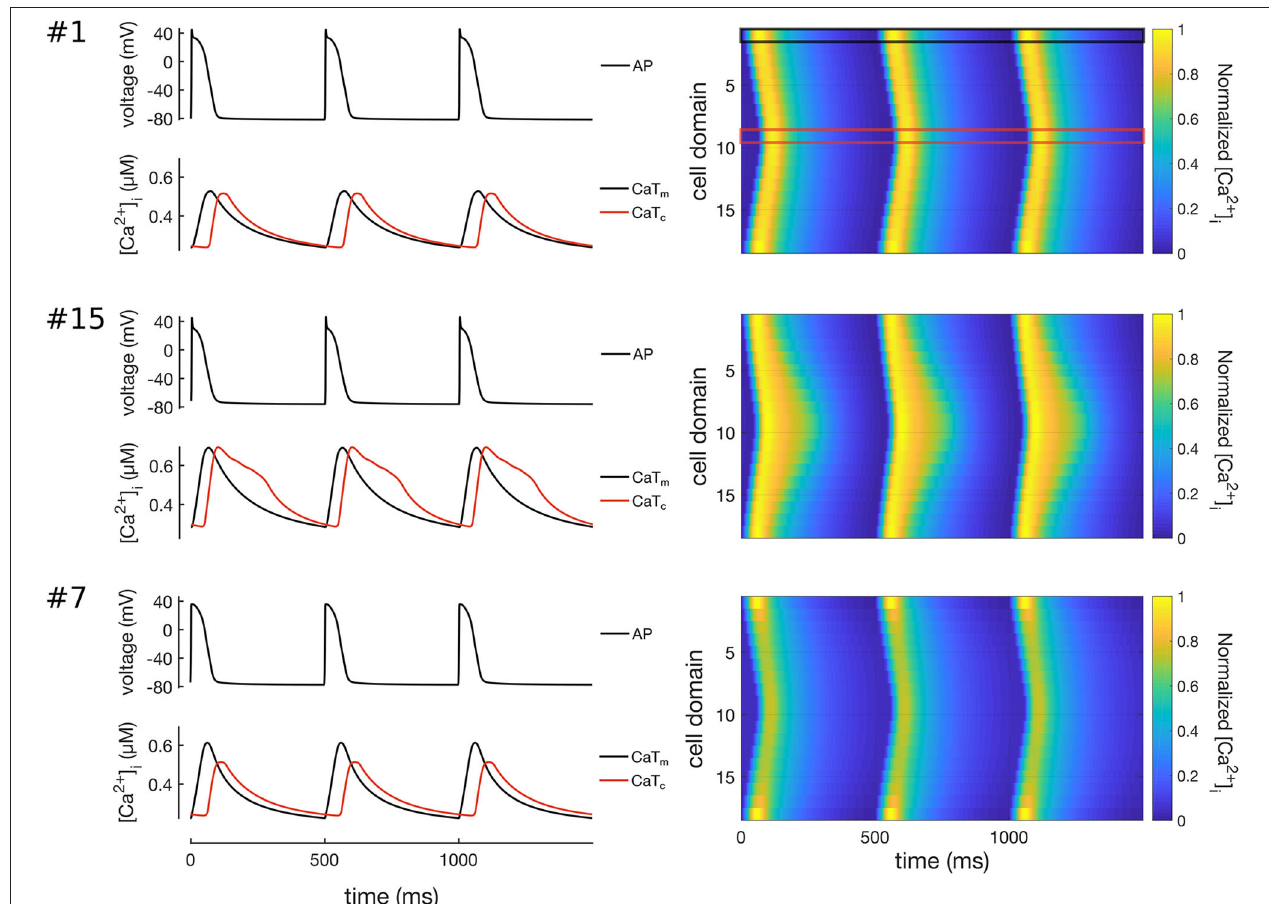
FIGURE 6 | Simulation of Ca 2 + waves in three representative models of the control population (models #1, #7, and #15). Traces on left hand-side show the APs (top), CaTs (bottom) at the membrane (CaT m , black lines) and centre of cell (CaT c , red lines). The right hand-side of the Figure shows line scans of propagating Ca 2 + waves in 3 simulated beats at 2Hz pacing. The black and red boxes on the top-right panel show the domains corresponding to the CaT m and CaT c traces. Model #1 shows a propagating Ca 2 + wave where CaT m and CaT c have rather similar morphologies; model #15 shows a Ca 2 + wave with slightly larger CaT delay ; and model #7 shows a wave patterns with decreased CaTA c as compared to CaTA m .